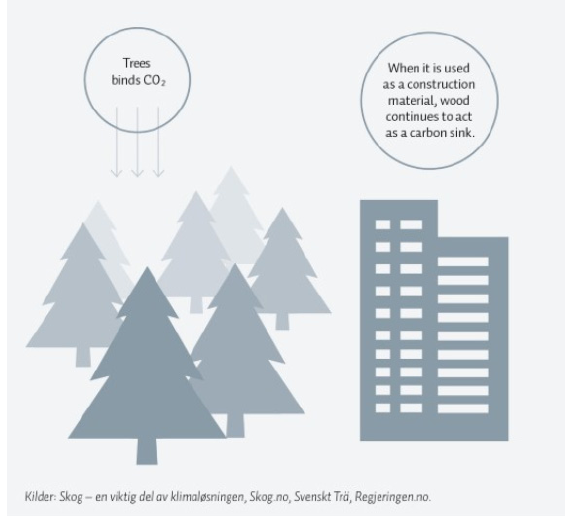
Figure 1. The impact of forestry on the climate [2].